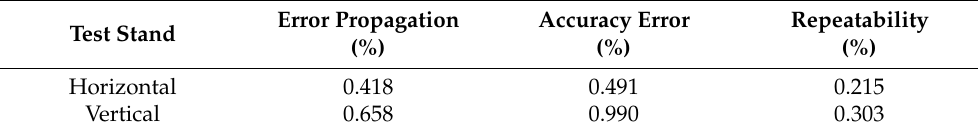
Table 6. Results for the relative deviation of experiments in the test